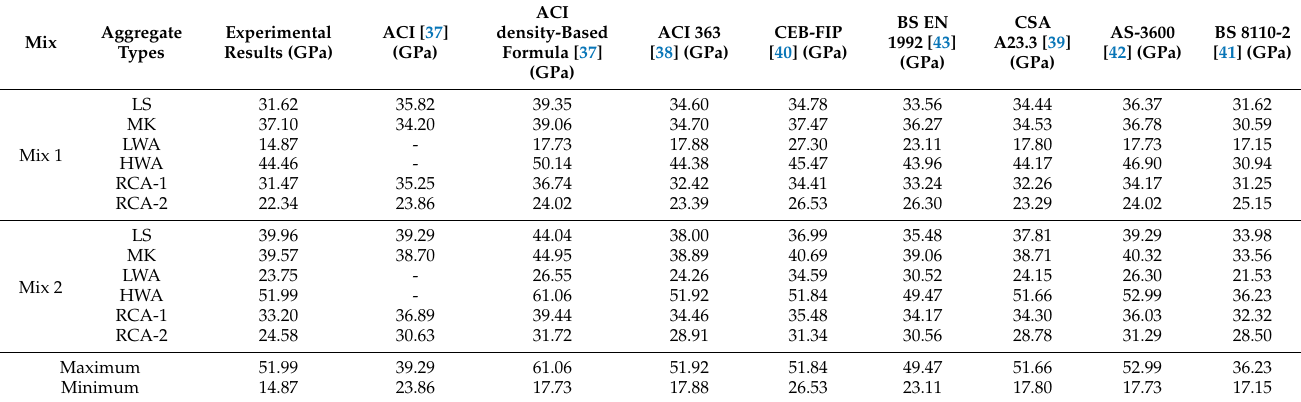
Table 5. Experimentally measured modulus of elasticity and calculated modulus of elasticity by various design codes.